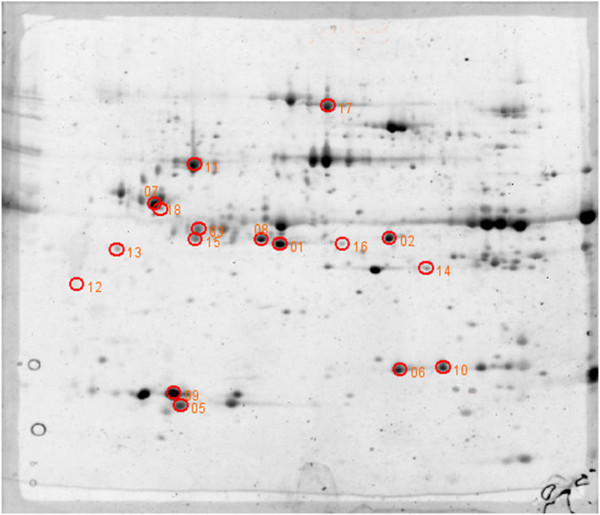
Spots up-regulated at 3DPI in CHIKV-infected salivary glands of Ae. aegypti. 130 μg of salivary gland extract from 3 DPI CHIKV-infected mosquitoes and control mosquitoes were loaded onto 3–10 NL immobilins (18 cm). The immobilins were then deposited on the top of 12% SDS-PAGE gels. Spots were revealed using SYPRO Ruby. Gel profiles were compared using Image Master Platinum software. The spots that were found up-regulated at 3DPI are indicated by circles (fold change>1.8; Anova<0.05).